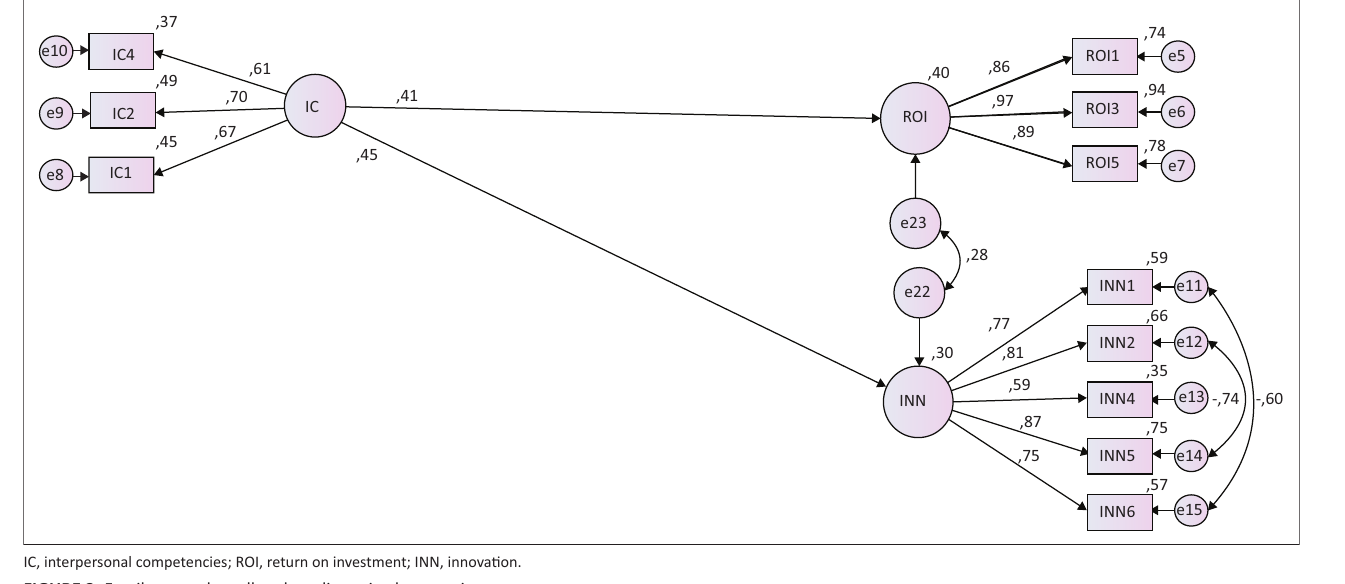
FIG URE 3: Family-owned small and medium-sized enterprises.